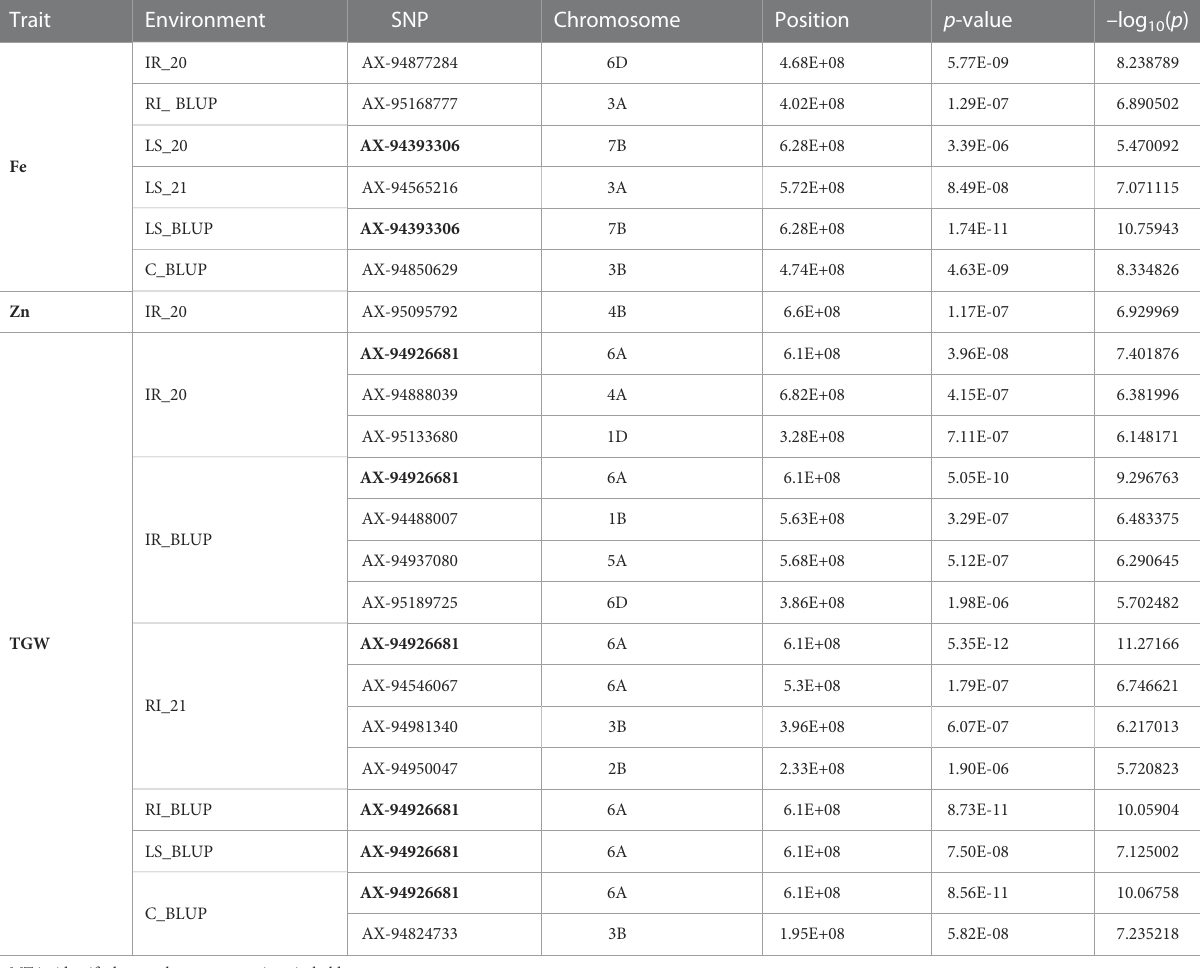
TABLE 4 Signi fi cant marker trait associations (MTAs) with a Bonferroni-corrected p -value ( – log 10 ( p ) > 5.45) for traits under study at each environment. Trait